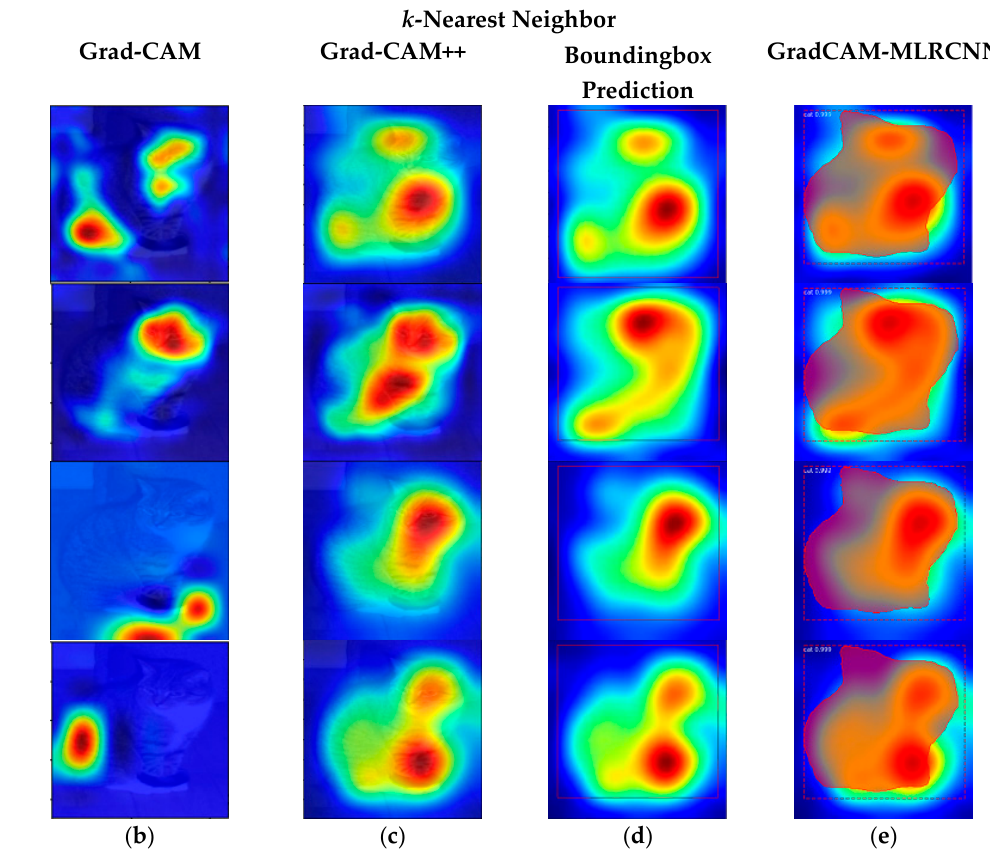
Figure 7. ( a ) Various pre-trained models; ( b ) results of Grad-CAM; ( c ) results of Grad-CAM++; ( d ) bounding box prediction on Grad-CAM++; and ( e ) GradCAM-MLRCNN.